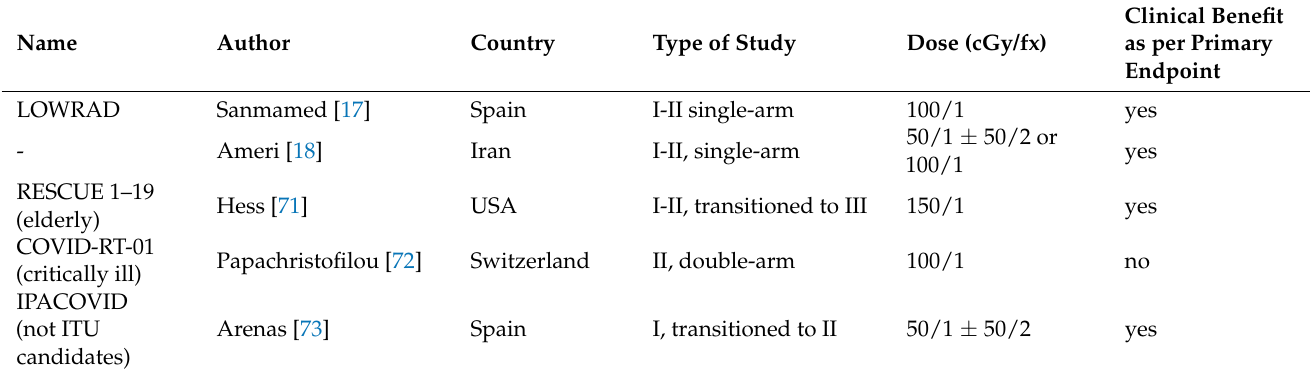
Table A2. LDRT published trials.